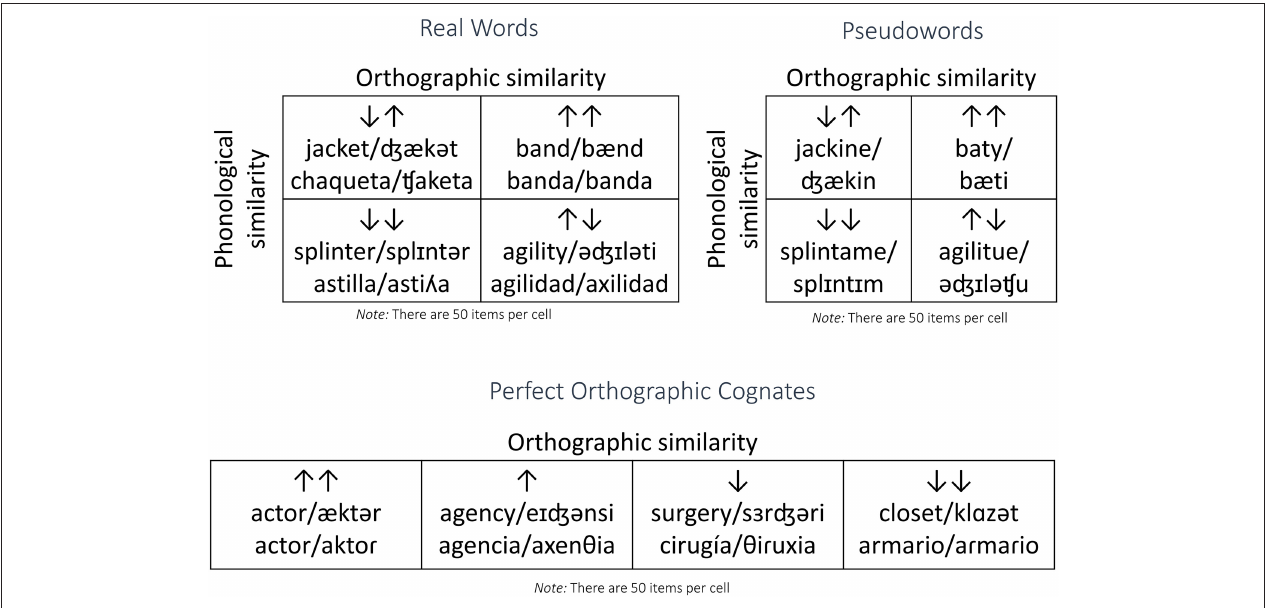
FIGURE 1 | Example stimuli in each similarity